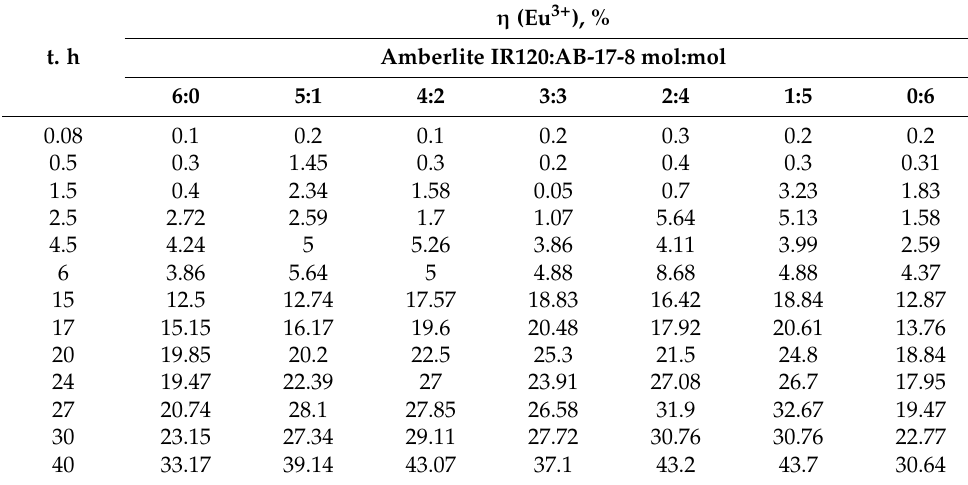
Table 1. Extraction degree of europium ions.